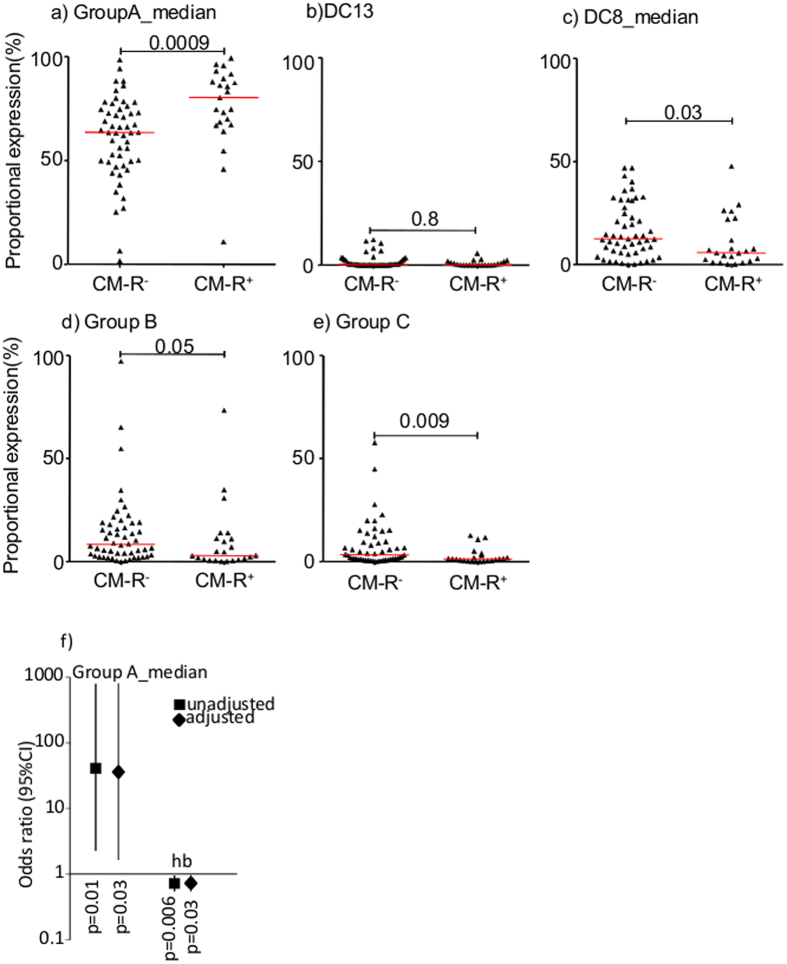
var transcript proportional expression and retinopathy.(a–e) are dot plots showing the proportional expression of broad classes of var genes in relation to retinopathy status. Each dot represents a parasite isolate from a child. Group A and DC8 proportional expression represented the proportions of the total measured var transcript contributed by groupA_median and DC8_median. GroupA median and DC8_median are defined in Fig.1 above but calculated in this case as Tus = 2(5-∆ct). (f) Shows a plot of odds ratio and 95%CI of logistic regression models predicting retinopathy. Shown on the left is the association between Group A proportional expression and retinopathy with and without adjusting for admission hemoglobin level. Also shown (on the right) is the association between admission hemoglobin and retinopathy with and without adjusting for group A proportional expression.